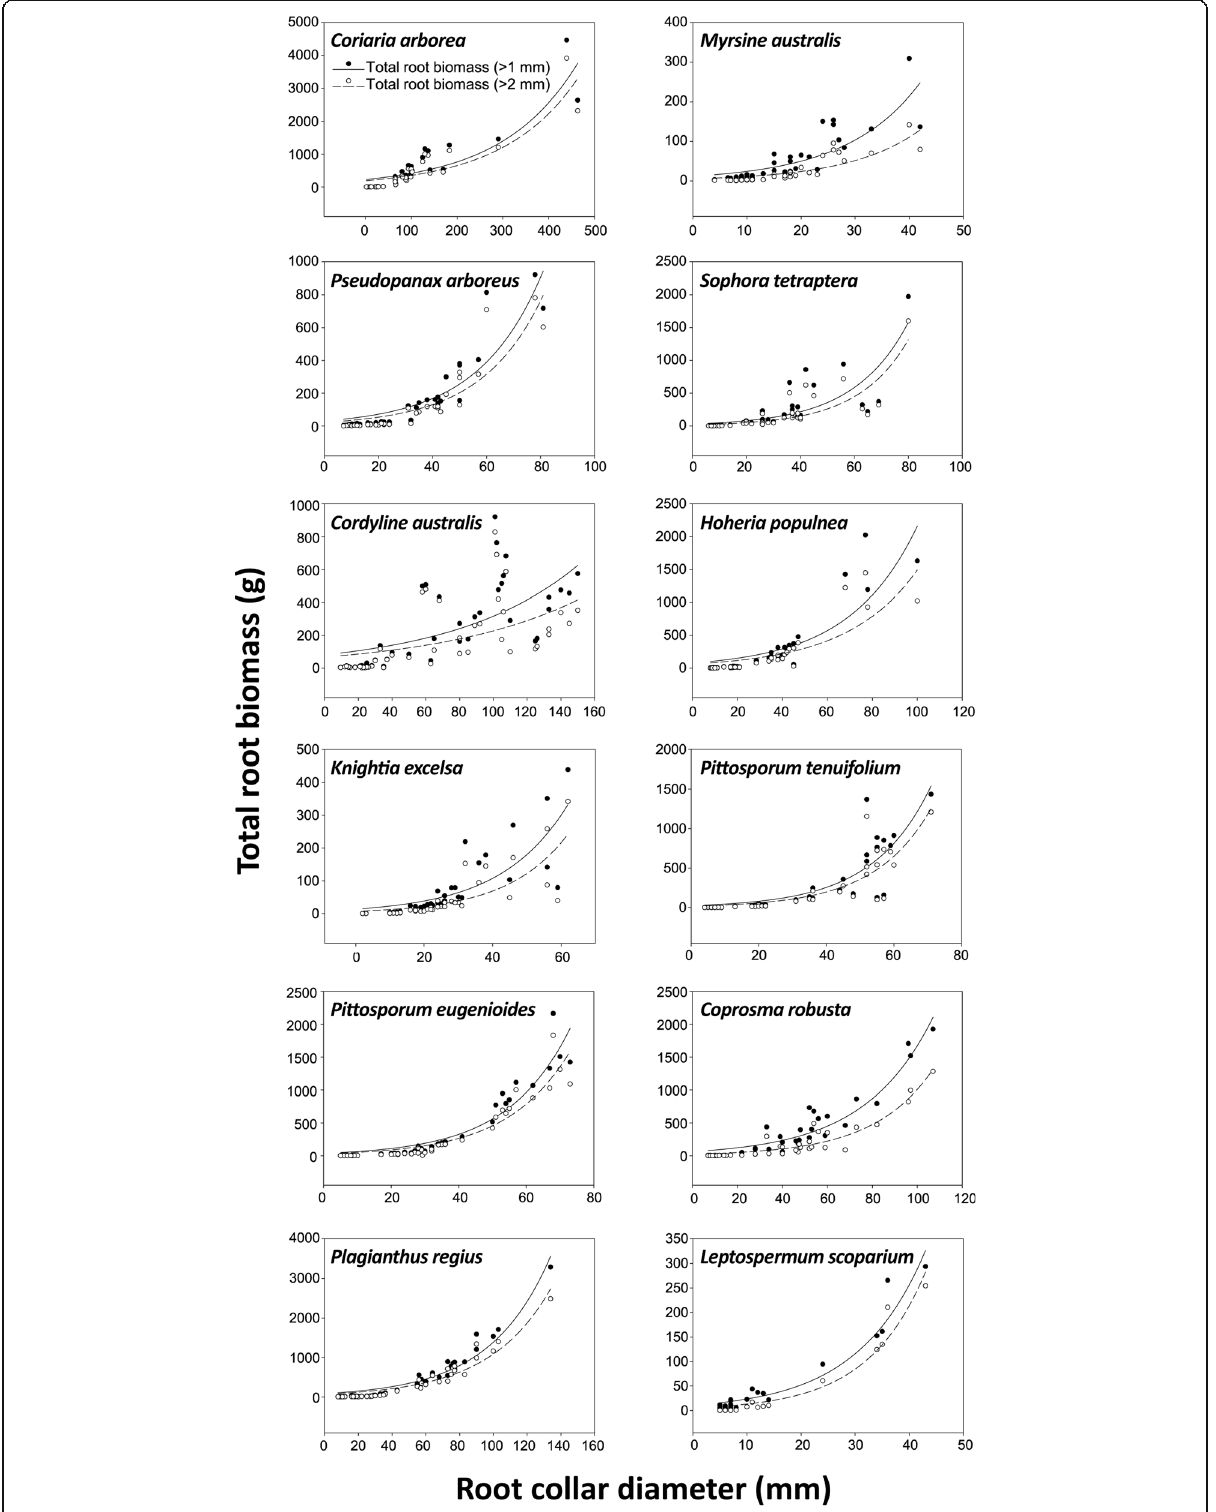
Fig. 4 Exponential growth analysis of RCD and total root biomass for roots >1 mm (black circle) and > 2 mm (white circle) diameter. Regression equations are presented in Table